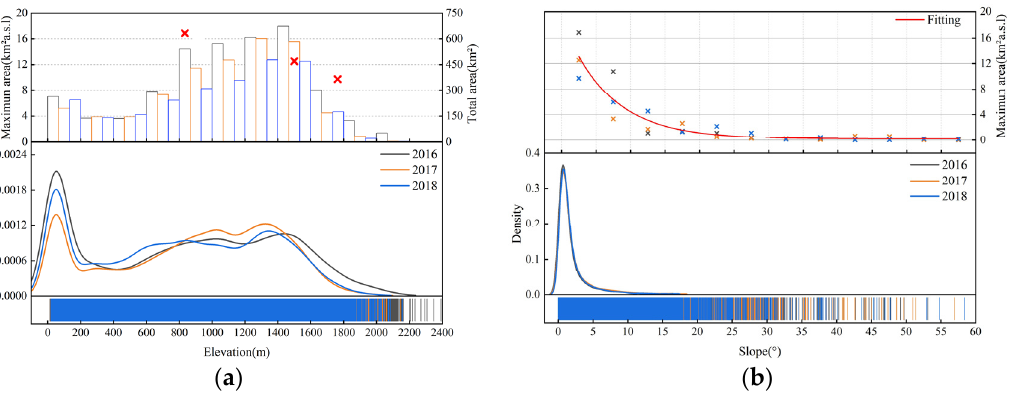
Figure 7. Topographic distribution of SGLs in Greenland from 2016 to 2018. Distribution of SGLs in different elevation ranges and slope ranges are indicated as follows. ( a ) The red labels (X) indicate the elevation range of the maximum lake per year. The two y-axes correspond to the values of the red labels ( left ) and the histogram ( right ) respectively. ( b ) The red curves indicate the exponential fit of the maximum lake area to the slope interval. The color of the X label corresponds to the color of the year. The large quantity of data led to overlapping curves, resulting in only the 2018 data being clearly